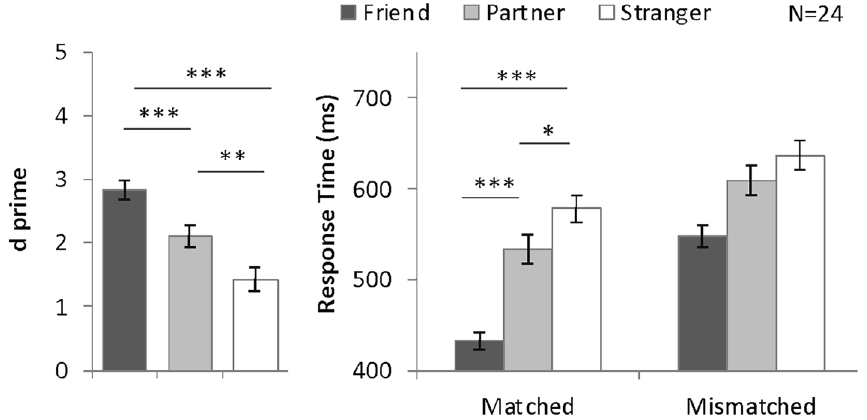
Figure 2. Mean and SE of d ′ and RT for different shape categories in Experiment 1. * P < 0.05, ** P < 0.01, *** P < 0.001.